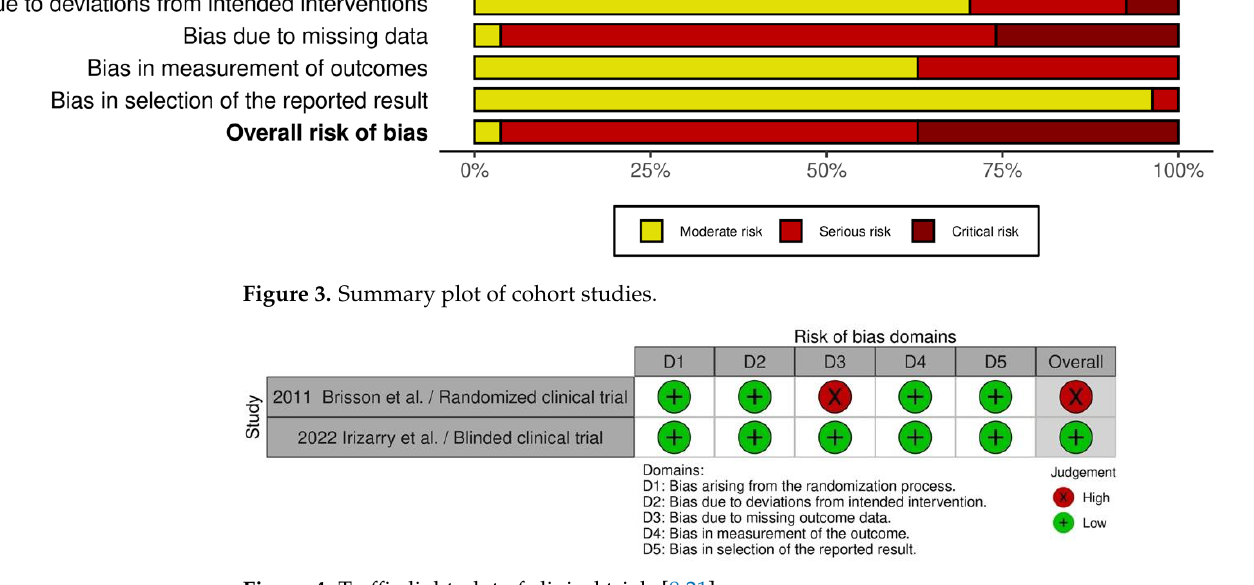
Figure 4. Traffic-light plot of clinical trials [8,21].